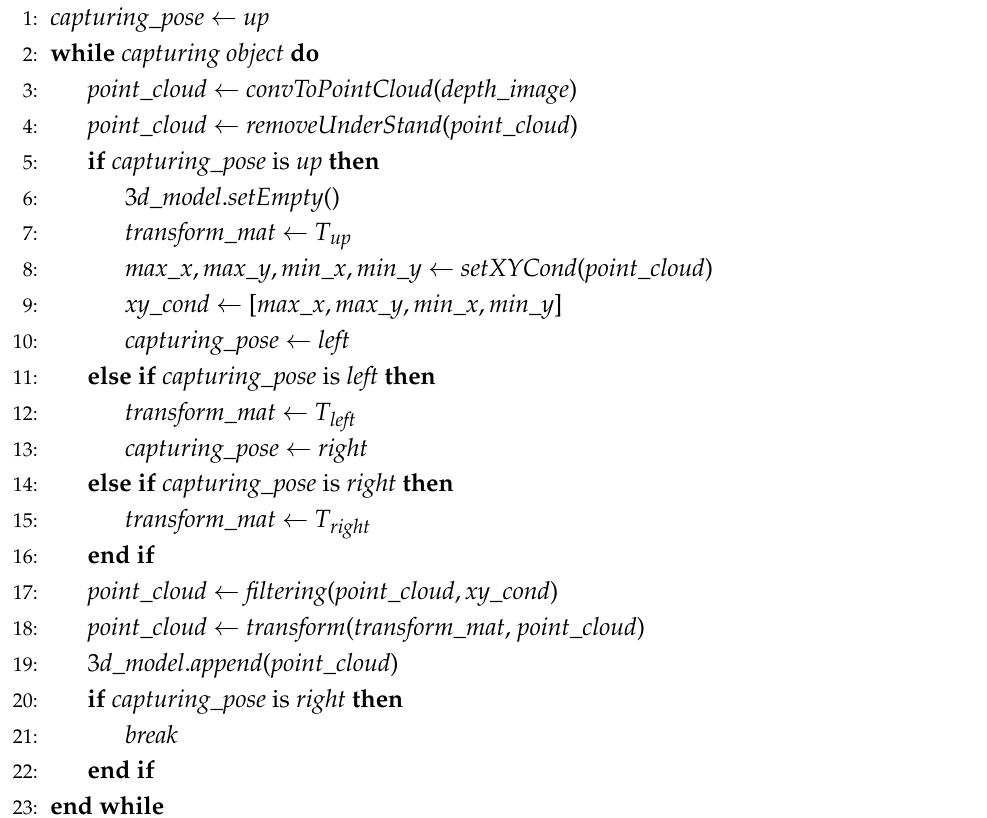
Algorithm 1 Three-Dimensional Reconstruction